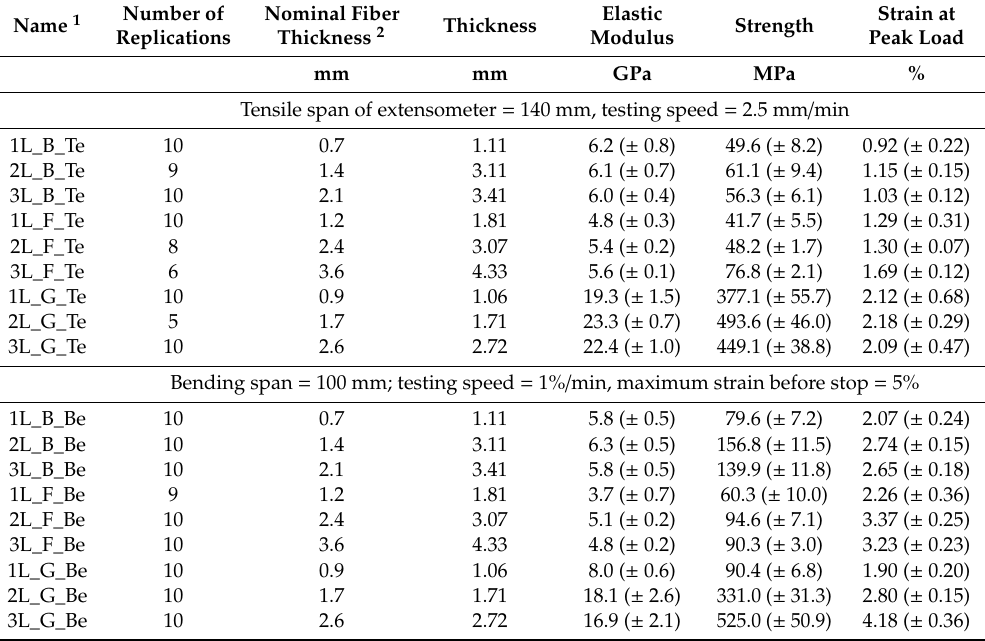
Table 2. Testing result of flat coupon tensile test and standard three-point bending test of FRP